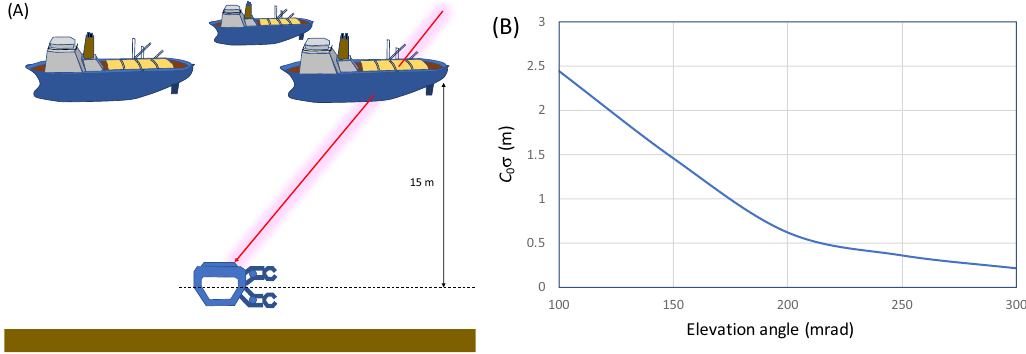
Figure 9. Conceptual view of the undersea MuWNS in conjunction with the Robotic Vessels as-a-Service (RoboVaaS) ( A ). Yellow panels on the Unmanned Surface Vehicles (USVs) indicate the reference detectors to navigate an Unmanned Underwater Vehicle (UUV). The red line indicates the muon trajectory. The c 0 σ as a function of the muon arrival angles from the horizon is also shown ( B ). The copyright of this image is owned by HKMT.